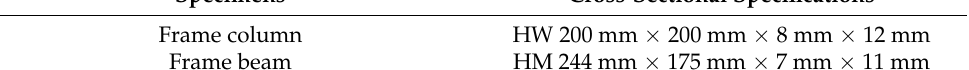
Table 2. The steel frame’s main dimensions.